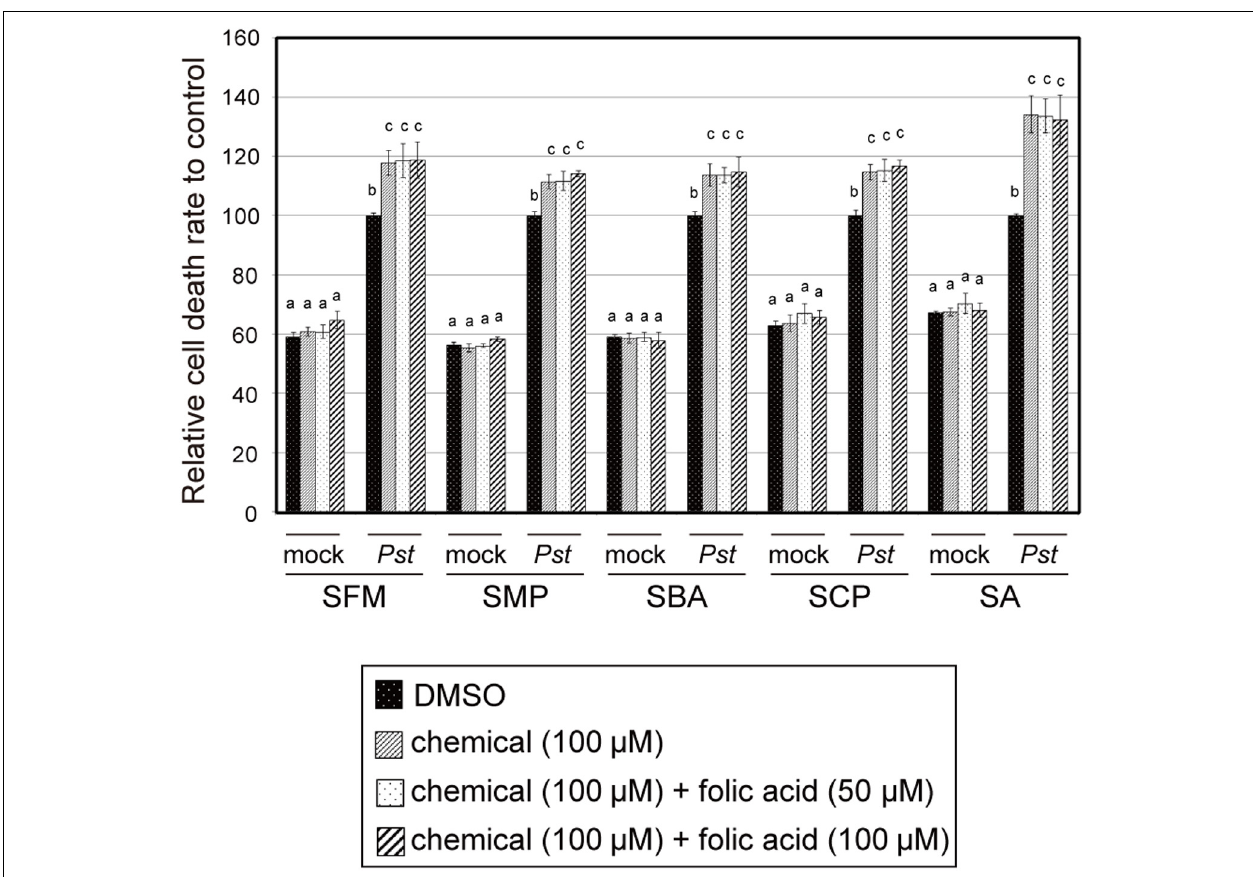
FIGURE 9 |The effect of folate on the sulfonamide-dependent cell death enhancement of Arabidopsis suspension cultures induced by Pst-avrRpm1 . The sulfonamide compounds and folate were incubated with Arabidopsis suspension-cultured cells at the indicated concentrations, with or without the avirulent bacterial pathogen Pst-avrRpm1 , and the degree of cell death was measured in terms of the concentration of Evans blue dye. Each